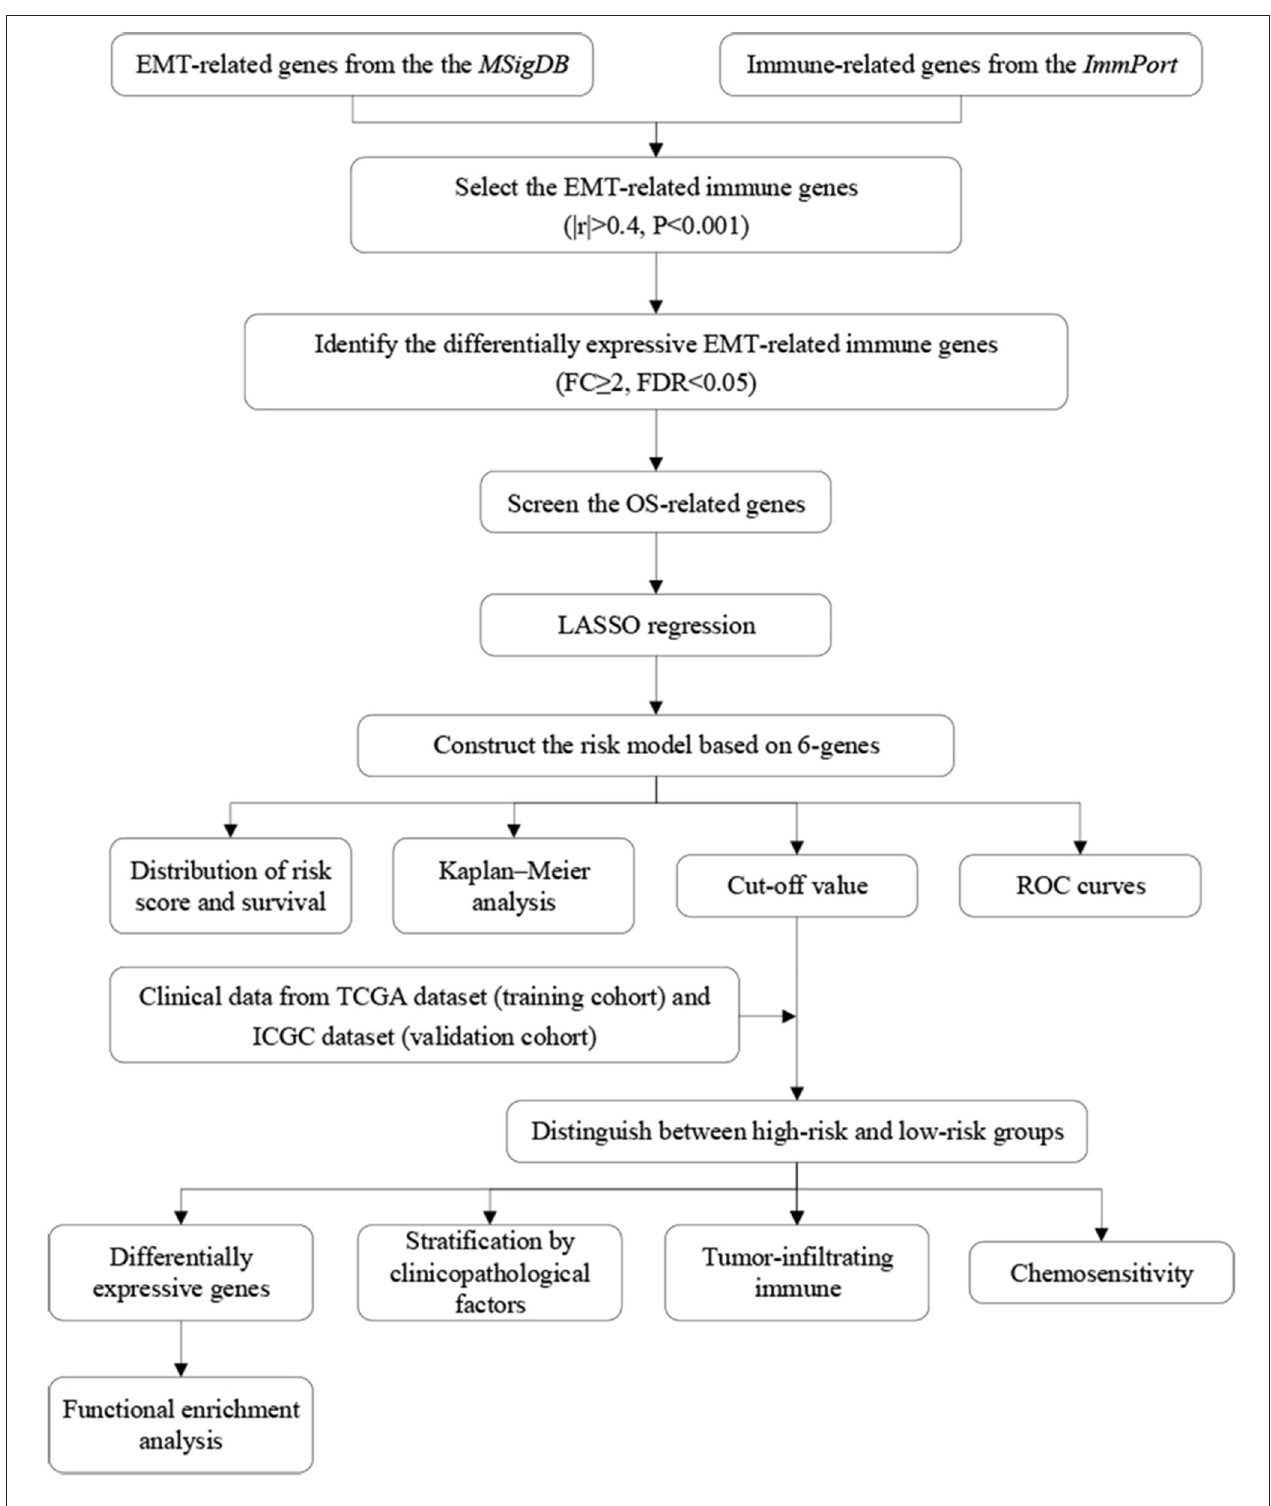
FIGURE 1 | Flow diagram of the